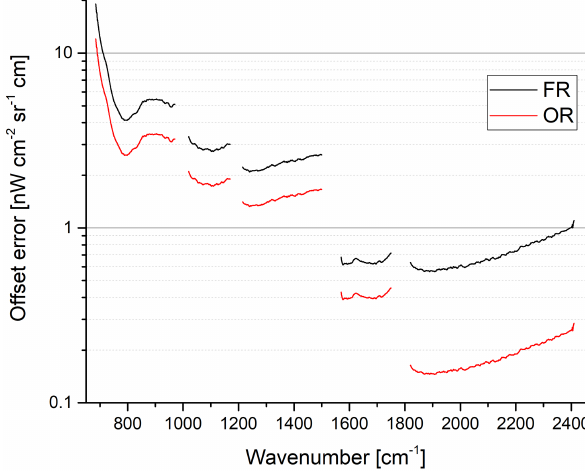
Figure 8. Offset error due to noise in the offset measurements.